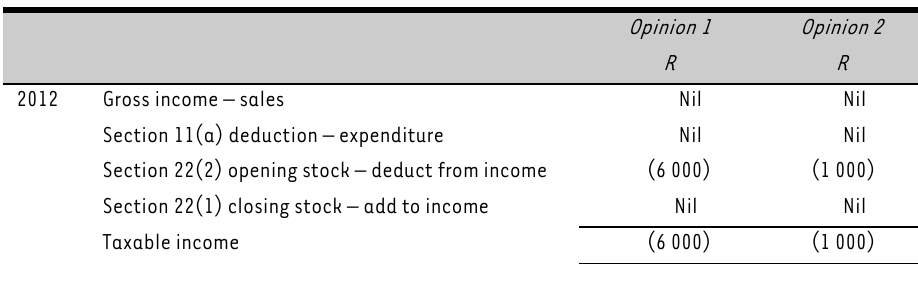
Speculative intention: tax implications of unsuccessful prospecting